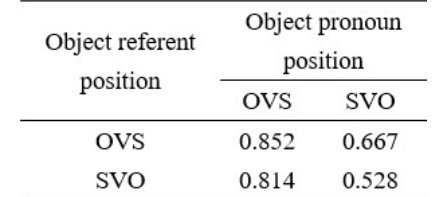
Table 3. Mean proportion of responses identifying the referent in object position as the antecedent of object